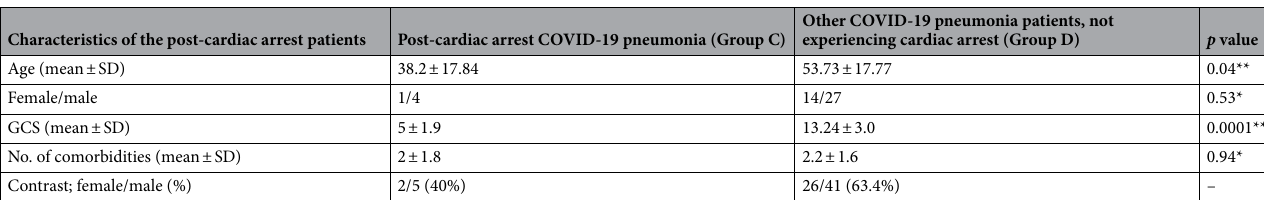
Table 3. The characteristics of the post-cardiac arrest patients, whose brain MRI showed global hypoxic- ischemic encephalopathy in four patients (80%) versus other patients with SARS-CoV-2 pneumonia. *Significant correlation ( p ≤ 0.05). **No significant correlation ( p >